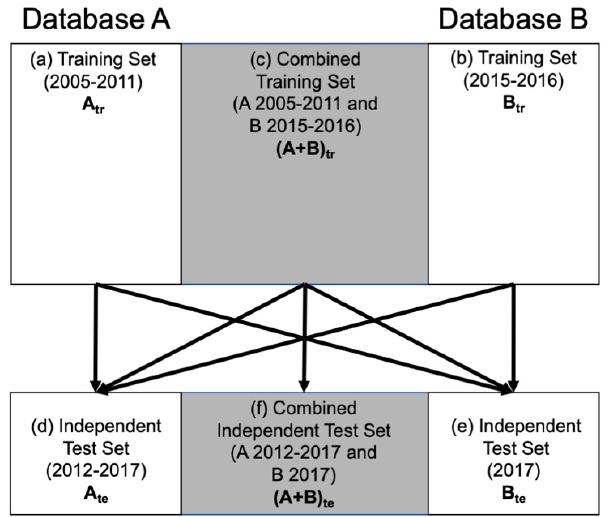
Figure 4. Framework for independent training and test between each set. Each arrow originates in a training set and terminates in an independent test set. Years of image acquisition are indicated in parentheses.